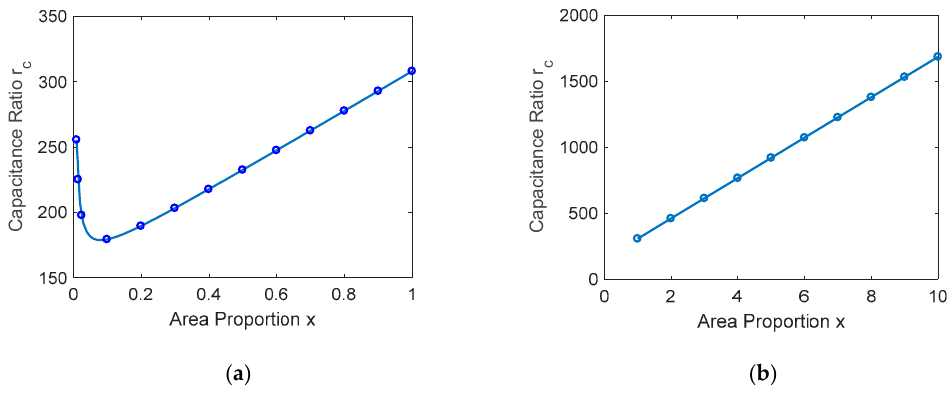
Figure 5. The relationship between x and r c . ( a ) x ∈ [ 0,1 ] ; ( b ) x ∈ [ 1,10 ]